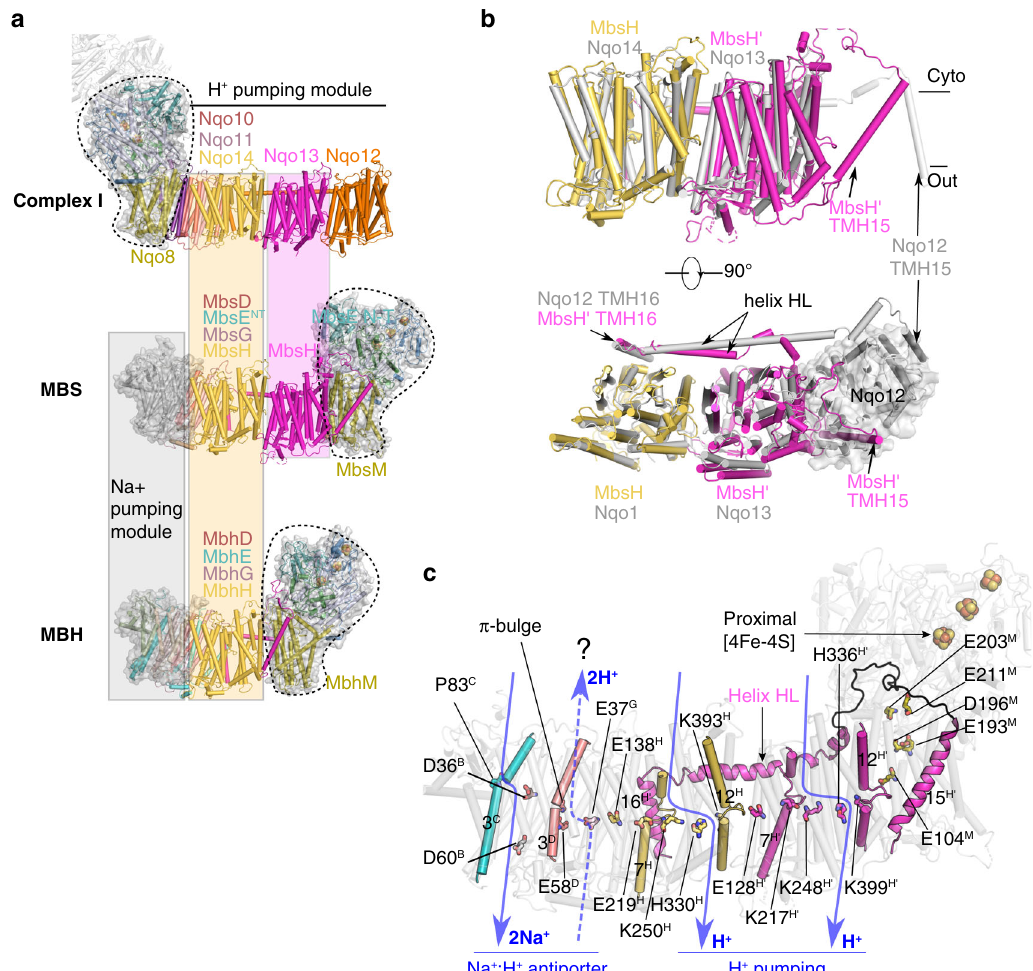
Fig. 3 Assembly of the modular architecture of MBS and comparison with complex I and MBH. a Complex I ( T. thermophilus ; PDB ID 4HEA) is lined up with MBS and MBH ( P. furiosus ; PDB ID 6CFW) via their respective proton-pumping subunit Nqo14, MbsH, and MbhH. The alignment detail is shown in Fig. S4. The complexes are shown separately for clarity. All complexes have a similar peripheral arm (dashed outline) anchored either to the left end (complex I) or to the right end (MBS and MBH) of their respective membrane arm. Complex I has 3, MBS 2, and MBH 1 H + -pumping subunits. MBS and MBH, but not complex I, have a Na + translocation module. b Superimposition of the two antiporter-like subunits of MBS (MbsH, MbsH ’ ) and complex I (Nqo14, Nqo13), by aligning MbsH with Nqo14 as in ( a ). Top, side view with complex I Nqo12 TMH1-14 hidden; bottom, top view with complex I Nqo12 TMH1-14 shown as cartoon and marked by the transparent surface. Note that the length of helix HL is evolved to match the number of antiporter-like subunits present in MBS and complex I. c The potential Na + and H + translocation paths in MBS. The Na + path and the adjacent H + path together form the potential Na + /H + antiporter module in the distal end of the membrane arm. The question mark above the proton path in the antiporter module indicates the tentative nature of the assignment. In the three H + paths, key residues conserved with complex I are shown as sticks. In the Na + path, key residues conserved with MBH and Mrp are shown as sticks. A series of charged and protonatable residues extend from MbsM to MbsH and MbsH ’ to form the charged axis across the membrane